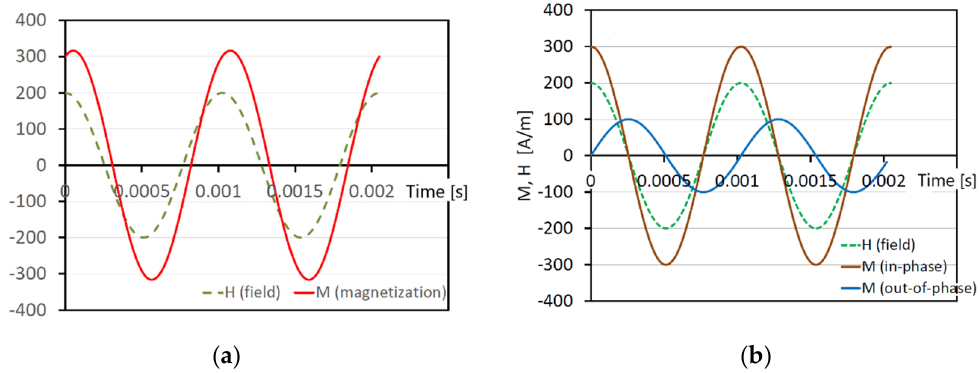
Figure 1. Definition of in-phase and out-of-phase components of AC susceptibility: ( a ) magnetization delayed behind the field, and ( b ) delayed magnetization resolved into in-phase and out-of-phase components. For the sake of better illustration, susceptibility is considered larger than 1, although it is much less than 1 in common rocks.